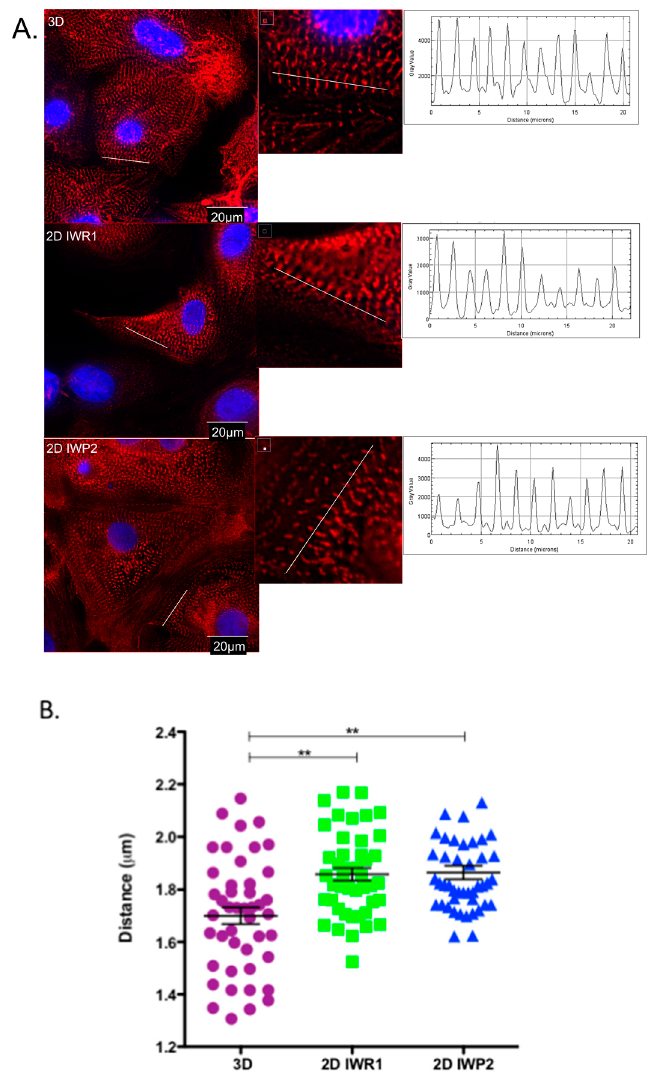
Figure 3. Measurement of the sarcomere length. ( A ) Deconvolution microscopy imaging of hiPSC-CM in the three differentiation protocols. α -sarcomeric actinin is stained in red and nucleus in blue. The sarcomere was measured by tracing a line of 20 µm across the sarcomeres using the Fiji software. The intensity of fluorescence across the line was translated into longitudinal plots; ( B ) Distribution of the sarcomere sizes. n = 45 cells for each protocol, from three different differentiations and three different iPSC clones. ** p < 0.01.